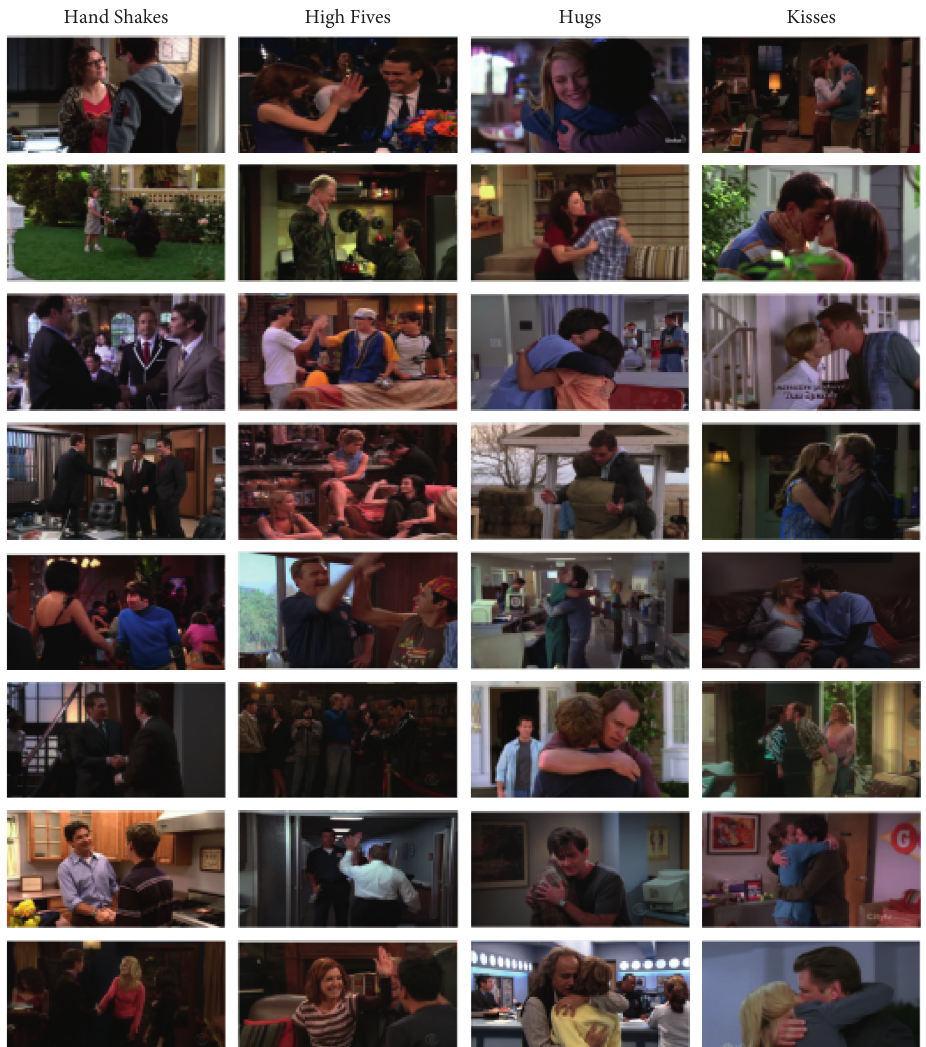
Figure 2: The TV human interaction